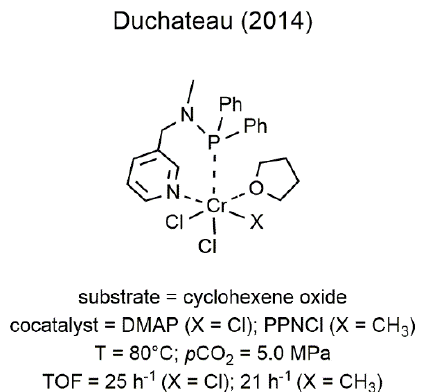
Figure 7. Chromium(III)-Aminophosphine complexes developed by Duchateau for the coupling of CO 2 with CHO [58].